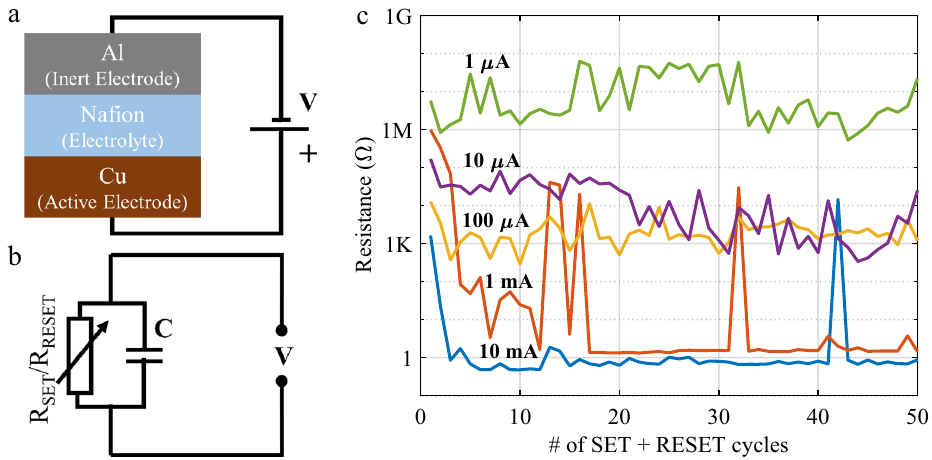
Figure 1. ( a ) Schematic of the MIM stack. ( b ) Equivalent circuit. ( c ) Test results of 50 consecutive SET-RESET operations each on five different cells with current limits Ilim = 10 mA, Ilim = 1 mA, Ilim = 100 µA, Ilim = 10 µA and Ilim = 1 µA, SET triangular pulse sweep rate = 2.8 V/s and RESET rectangular pulse width = 1